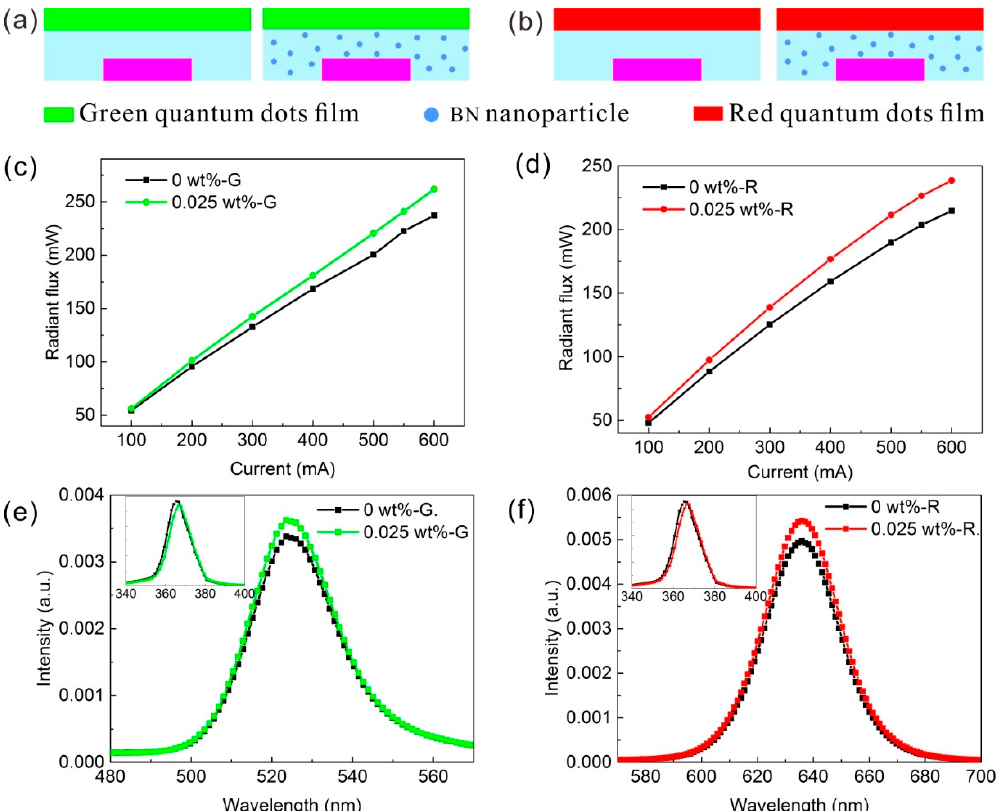
Figure 10. Schematic of UVLED excitation of ( a ) green quantum dot films and ( b ) red quantum dot films, with and without BN NPs. ( c ) Radiant flux of green-UVLED and ( d ) red-UVLED, versus current. ( e ) Electroluminescence spectra of green-UVLED and ( f ) red-UVLED, for current of 500 mA. The inset graphs ( e , f ) show the spread of the ultraviolet excitation peak.